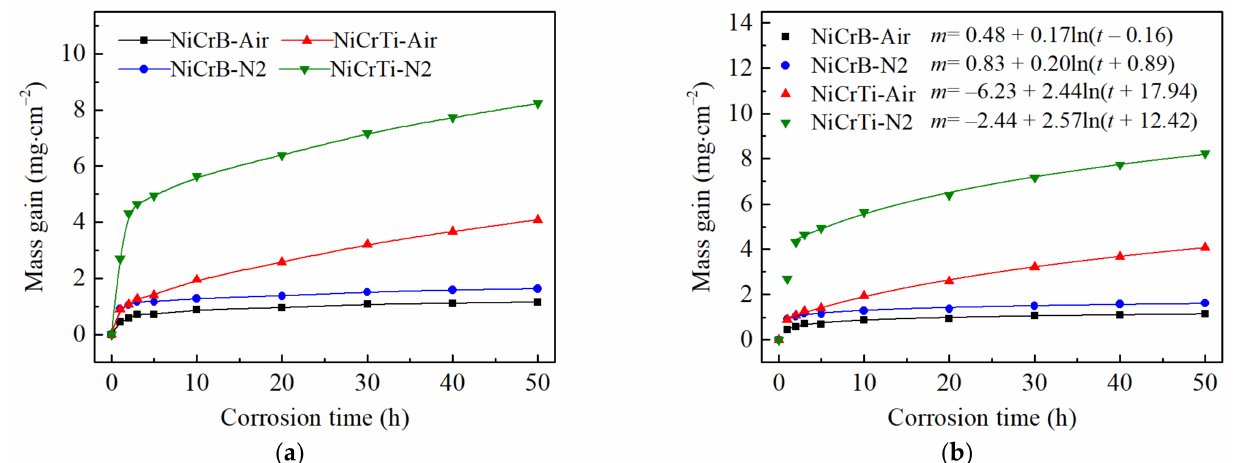
Figure 4. Corrosion kinetic curves of air-atomized and nitrogen-atomized NiCrB and NiCrTi coatings with exposed to the salt Na 2 SO 4 -10 wt.% NaCl at T = 800 ◦ C for t = 50 h in air. ( a ) The plotted curves by mass gain and test duration. ( b ) The fitted curves and their equations based on mass gain and test duration. The letter m and t in the equations represent mass gain and corrosion time, respectively.